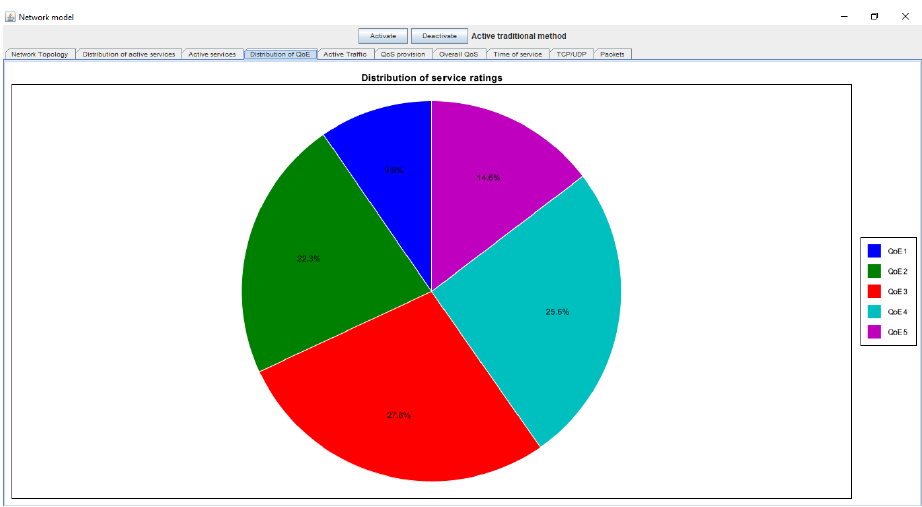
Figure 21. The distribution of network services relative to simulation time. Appl. Sci. 2020 , 10 , x FOR PEER REVIEW